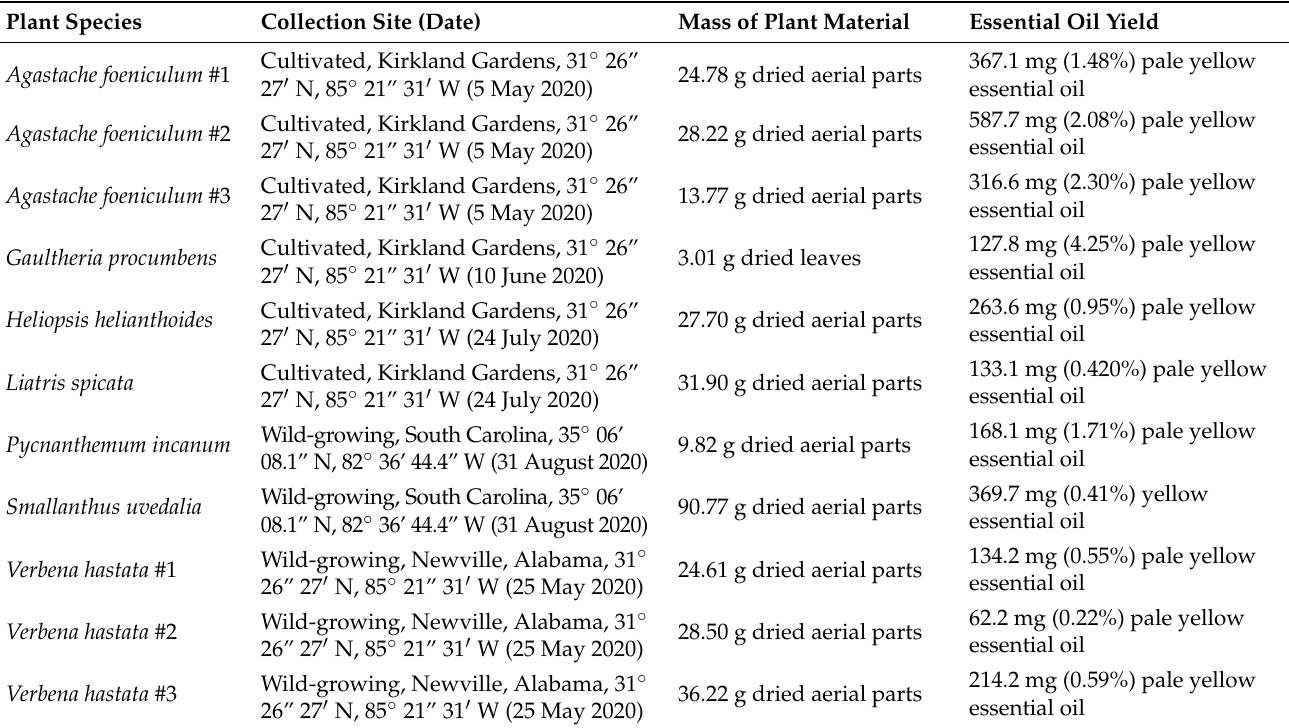
Table 1. Collection and hydrodistillation details of seven Native American medicinal plants a